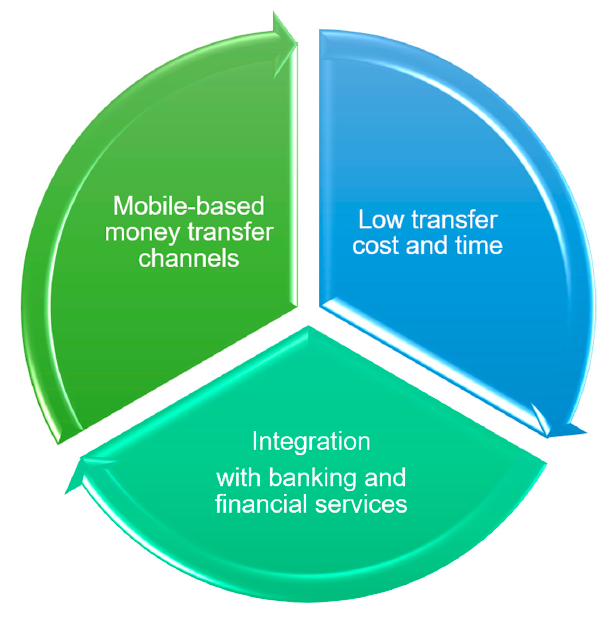
Figure 5. Remittance drivers.